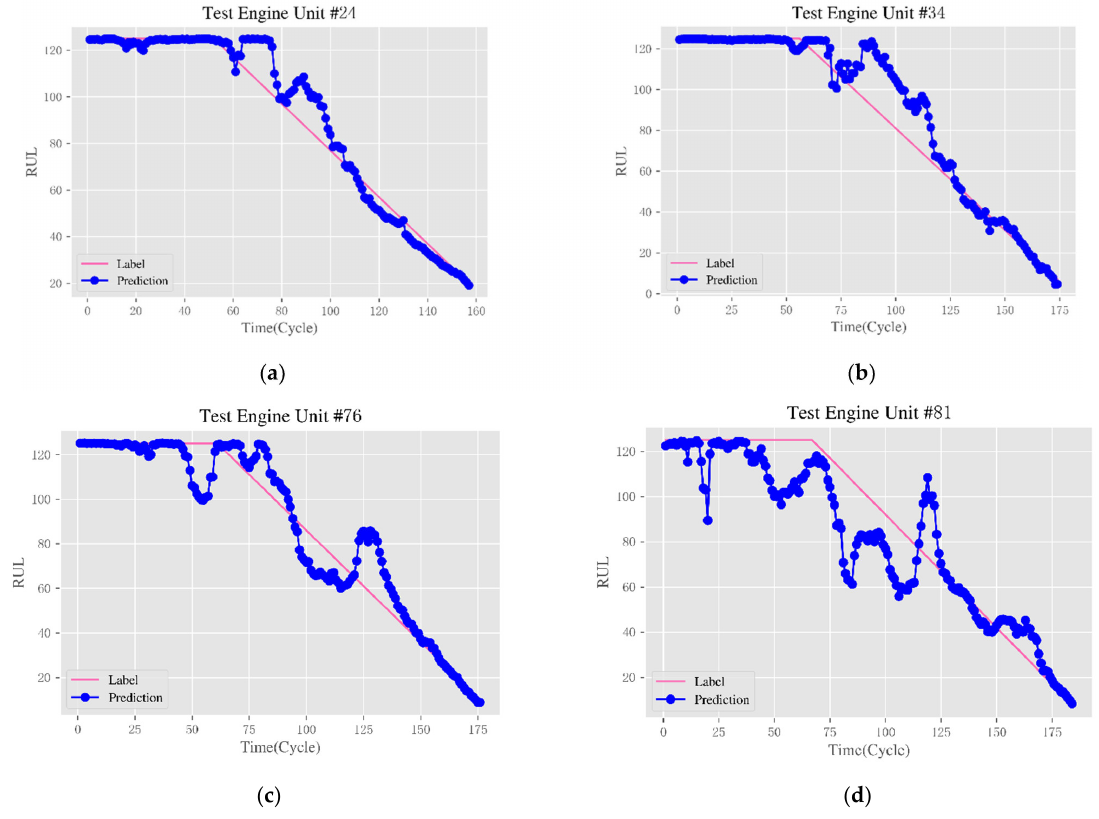
Figure 11. Full test cycle RUL prediction results for partially tested engines. ( a ) Unit 24; ( b ) Unit 34; ( c ) Unit 76; and ( d ) Unit 81.